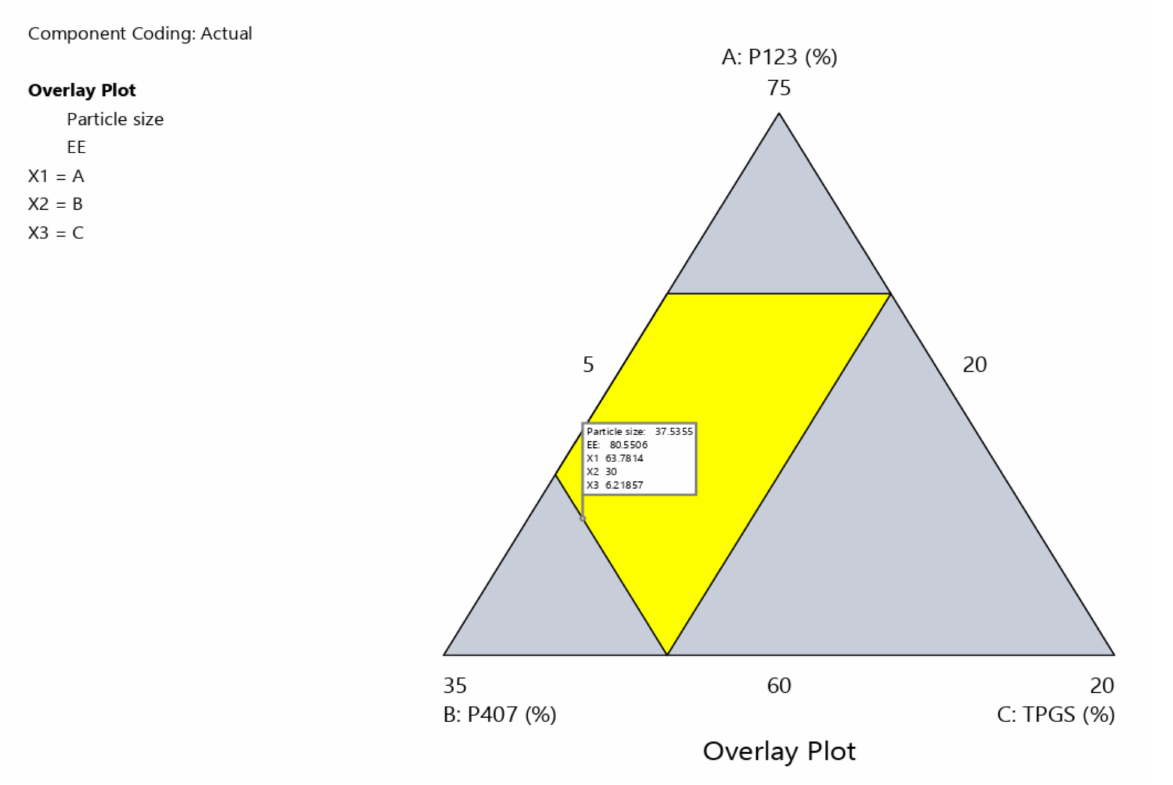
Figure 5. Design space region for the